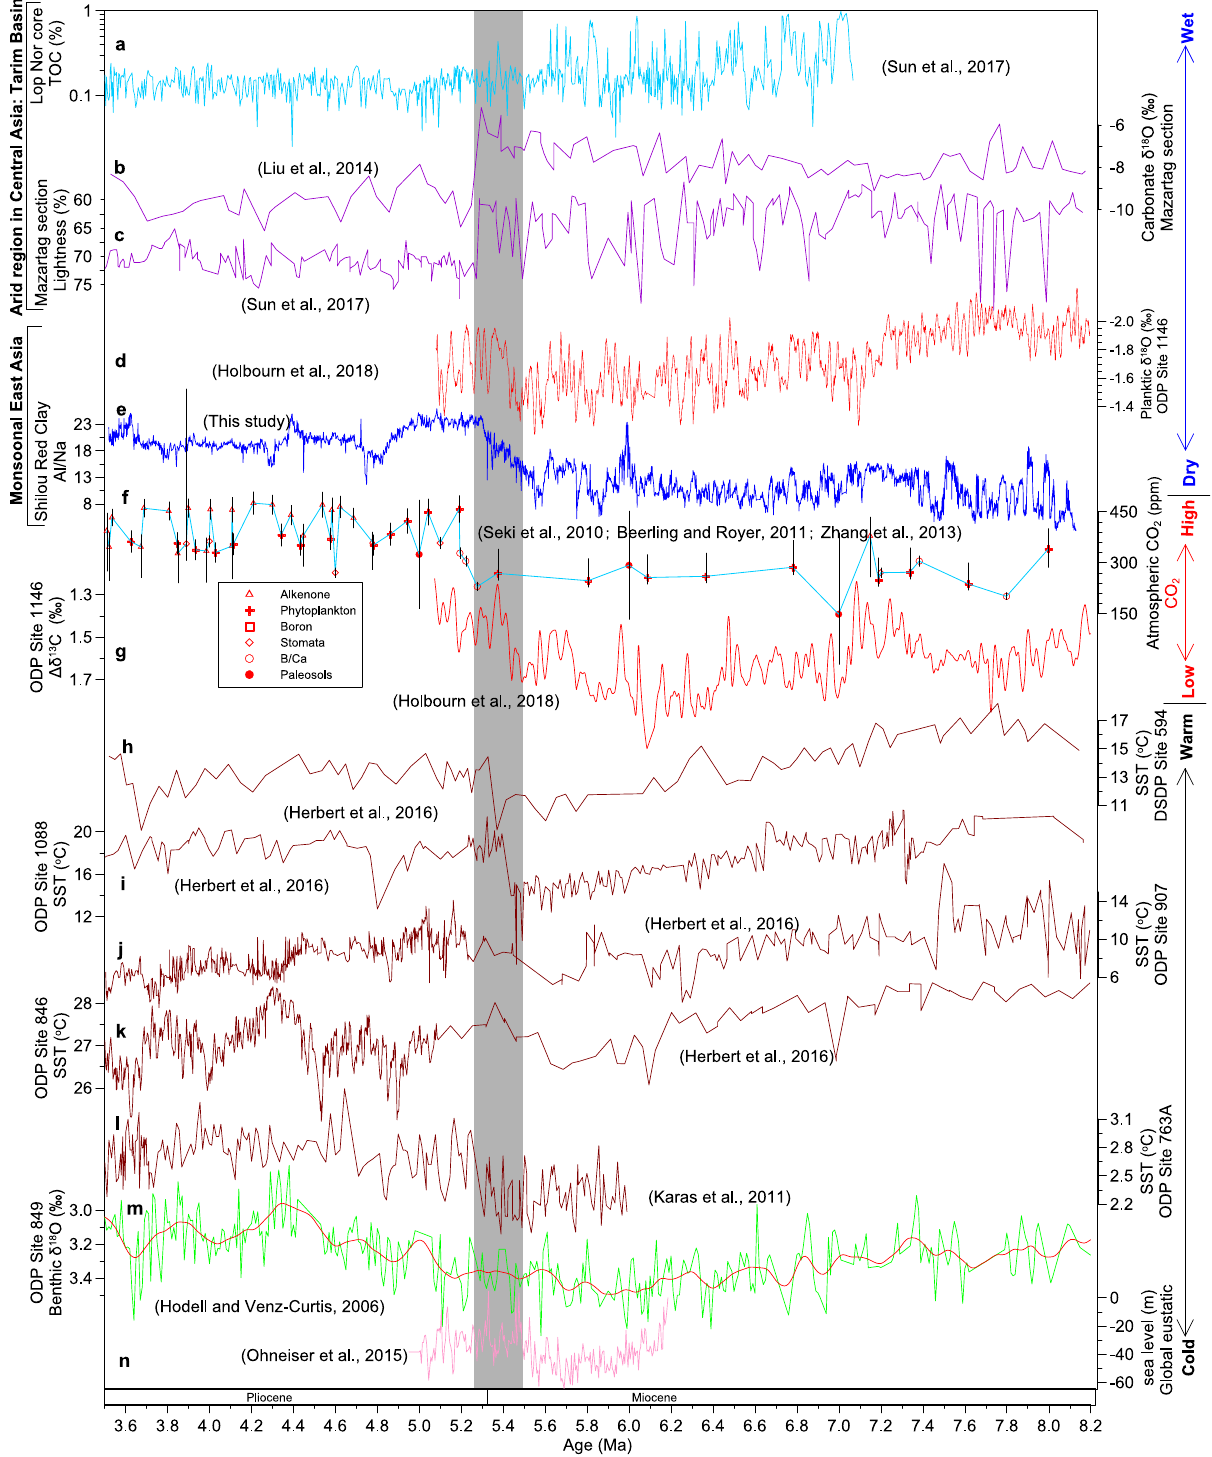
Fig. 4 Compiled records of Asian and global climate change across the MPB. a – c Total organic carbon (TOC), carbonate δ 18 O, and lightness records from the Tarim Basin 48,49 . d ODP Site 1146 planktic δ 18 O record 7 . e Al/Na from the Shilou red clay section (this study). f Compiled proxy record of atmospheric CO 2 concentrations from different methods, with error bars representing one-sigma uncertainties 8 – 10 . g Gradient between planktic and benthic foraminiferal δ 13 C at ODP Site 1146, South China Sea 7 . h – l Sea surface temperature (SST) reconstructions 6,39 from DSDP Site 594 (South Paci fi c Ocean) and ODP Sites 1088 (South Atlantic Ocean), 907 (Norwegian Sea), 846 (tropical eastern Paci fi c Ocean), and 763 A (subtropical southeastern Indian Ocean). m ODP Site 849 benthic foraminiferal δ 18 O record, tropical eastern Paci fi c Ocean 41 . The red smoothed curve is fi tted using the locally weighted least squares error (LOWESS) method with Matlab. n Modelled global eustatic sea level changes 5 . The compiled data indicate increased moisture in Asian monsoon areas and aridi fi cation in arid Central Asia, as CO 2 and temperature increased across the MPB (shaded).